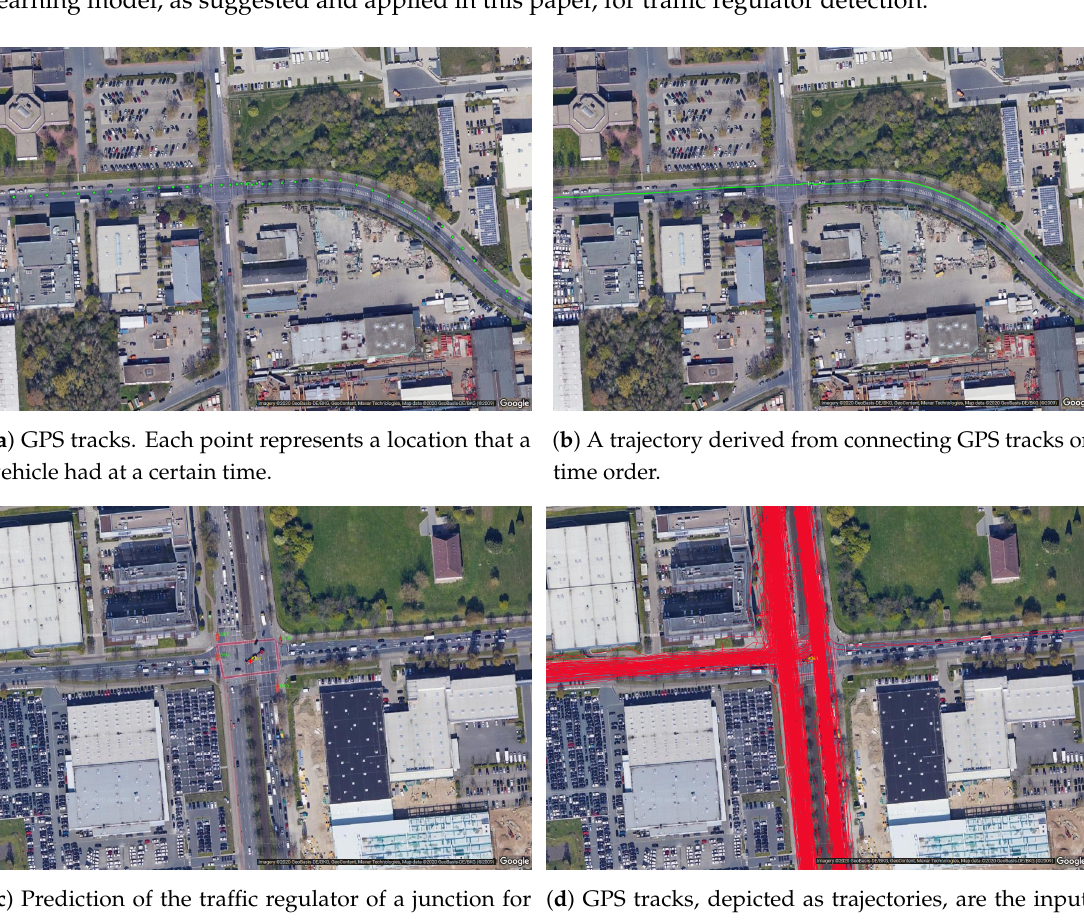
Figure 1. Geographical data collected from a mobile phone application, represented as points ( a , b ) trajectories. Map enriched with traffic regulators ( c ) from crowdsourced vehicles’ GPS tracks ( d